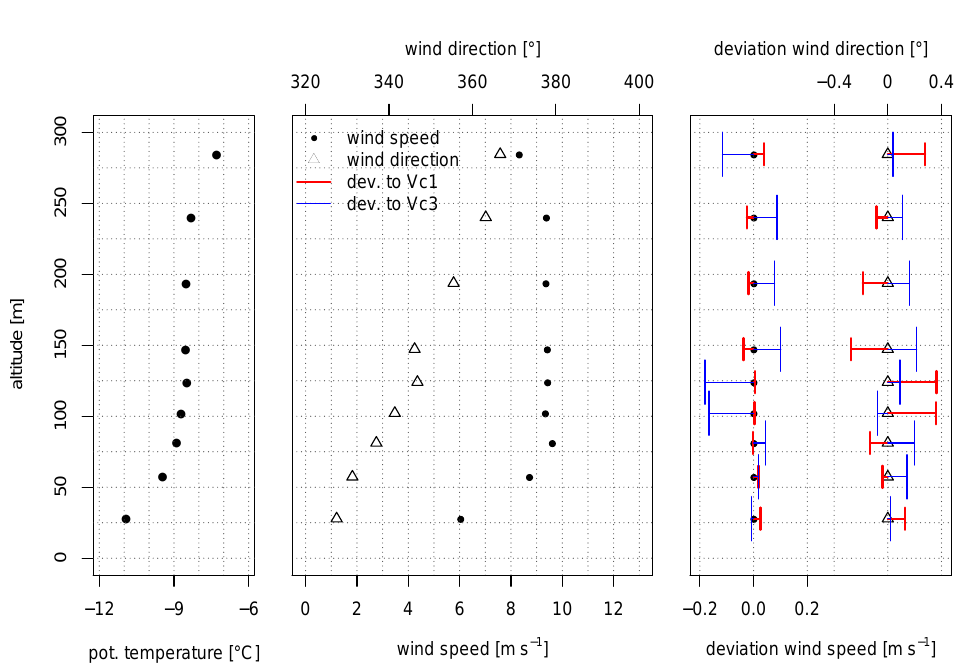
Figure 6. Height profiles of the ISOBAR flight with the altitude AMSL of the potential temperature ( left ), horizontal windspeed v h and wind direction φ , calculated with the calibration polynomial at v c 2 ( middle ). Deviations ( right ), when applying the calibration polynomials at v c 1 and v c 3